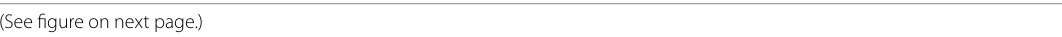
(See figure on next page.) Fig. 6 MTCH2 knockdown increases temozolomide-induced apoptosis of glioma cells. a , b Images ( a ) and quantifications ( b ) of Hoechst staining showing that MTCH2 knockdown promotes cell apoptosis of A172 cells after temozolomide treatment (200 μM, 48 h) (N d Images ( c ) and quantifications ( d ) of flow cytometry showing that MTCH2 knockdown promotes apoptosis of A172 cells after temozolomide treatment (200 μM, 48 h) (N 3). e , f Western blots ( e ) and quantifications ( f ) showing that MTCH2 knockdown alters cellular signalings relative to = cell survival/death (N =